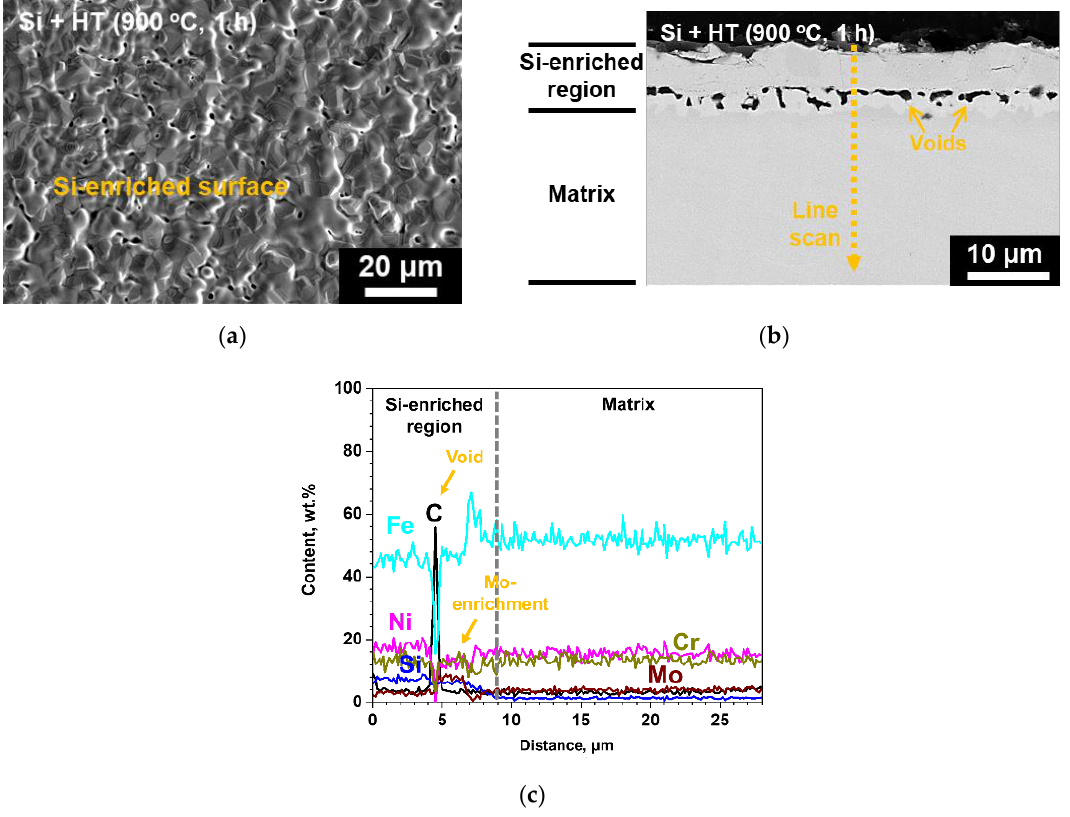
Figure 2. ( a ) Surface scanning electron microscopy (SEM), ( b ) cross-sectional backscattered electron (BSE) micrograph of the surface-modified SS 316LN, and ( c ) result of energy dispersive X-ray spectroscopy (EDS) line scan along the dotted line in (c).